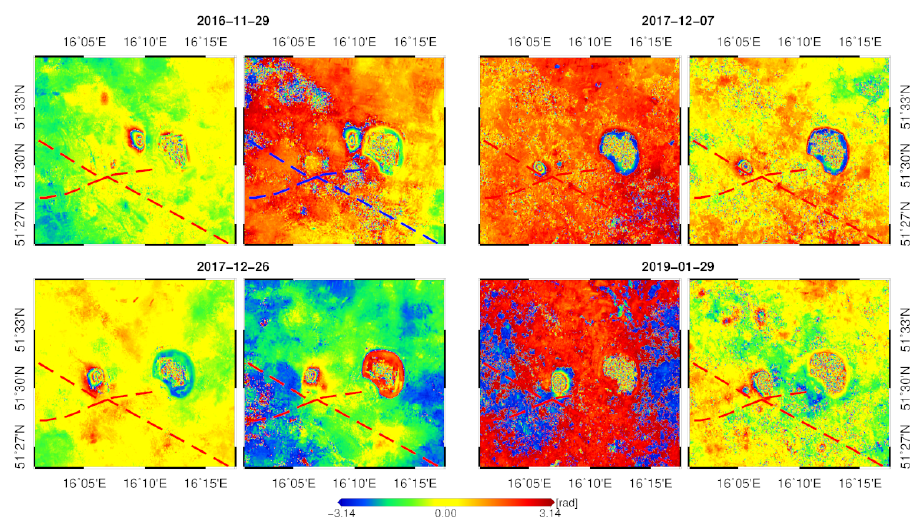
Figure 7. Interferograms (before unwrapping) calculated for four seismic events. Calculation results for paths ( left ) ascending (No. 73) and ( right ) descending (No. 22). The tectonic faults are marked on the maps with dashed lines: the Rudna Glowna fault (NW-SE) and the Biedrzychowa fault (SW-NE). The center of the trough which subsided due to the tremor on 29 November 2016 is located about one kilometer west of the western side of the Zelazny Most tailings pond. In the image of the vertical component, the trough assumes the shape of an ellipse elongated in the north–south direction. The calculated component indicates the maximum subsidence value in the analyzed period at − 82 mm in the vicinity of the center of the trough. The value is greater than the value read from the LOS results for the ascending path ( − 73 mm) and for the descending path ( − 67 mm). The image of the E-W horizontal component indicates horizontal displacements within the subsidence trough at +/ − 30 mm over the investigated period. The ground surface was displaced towards the center of the subsidence